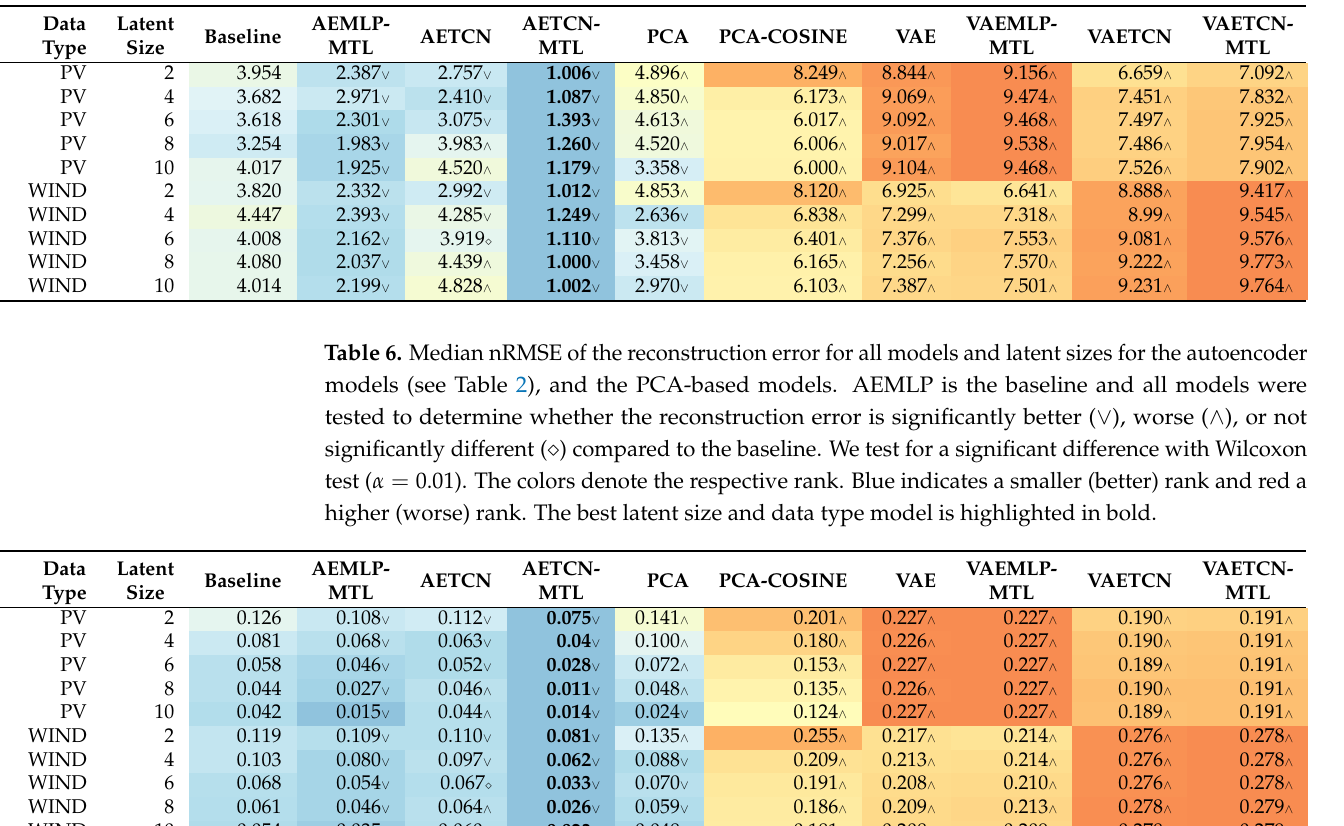
Table 5. Rank summary of the reconstruction error for all models and latent sizes for the autoencoder model (see Table 2), and the PCA-based models. AEMLP is the baseline and all models were tested to determine whether the reconstruction error is significantly better ( ∨ ), worse ( ∧ ), or not significantly different ( (cid:5) ) compared to the baseline. We test for a significant difference with the Wilcoxon test ( α = 0.01). The colors denote the respective rank. Blue indicates a smaller (better) rank and red a higher (worse) rank. The best latent size and data type model is highlighted in bold.